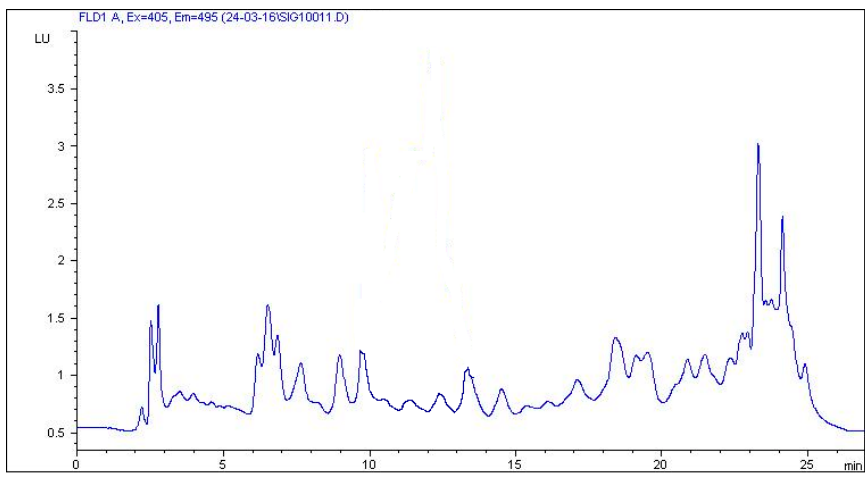
Figure 3. Chromatogram of blank feed sample.